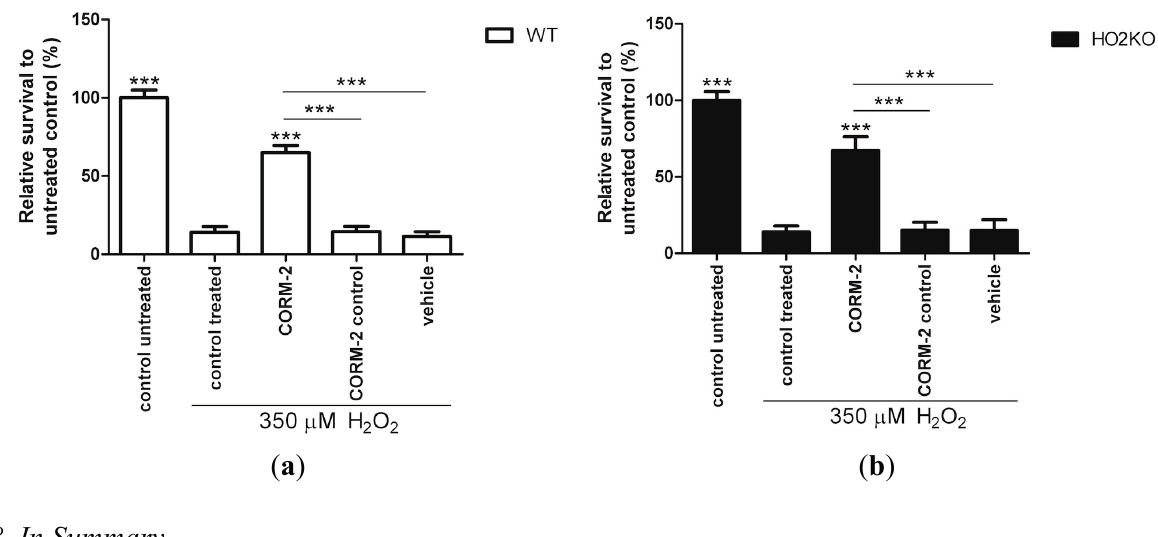
Figure 7. CORM-2 increases WT and HO-2 KO ASC survival against H 2 O 2 -induced cell death. ( a ) WT ASC and ( b ) HO-2 KO ASC survival after 24 h pre-treatment with CORM-2, or its controls, and 24 h co-treatment together with 350 µM H 2 O 2 following an Alamar blue assay and fluorimetric quantification, related to untreated control. Vehicle consisted of 0.1% DMSO (CORM-2 and CORM-2 control solvent) in culture media. * is significant different from treated control. ( *** p < 0.001). Experiments are performed in triplicate with samples in sextet. Representative graph is shown. Data are presented as mean ± SD. CORM-2: CO-releasing